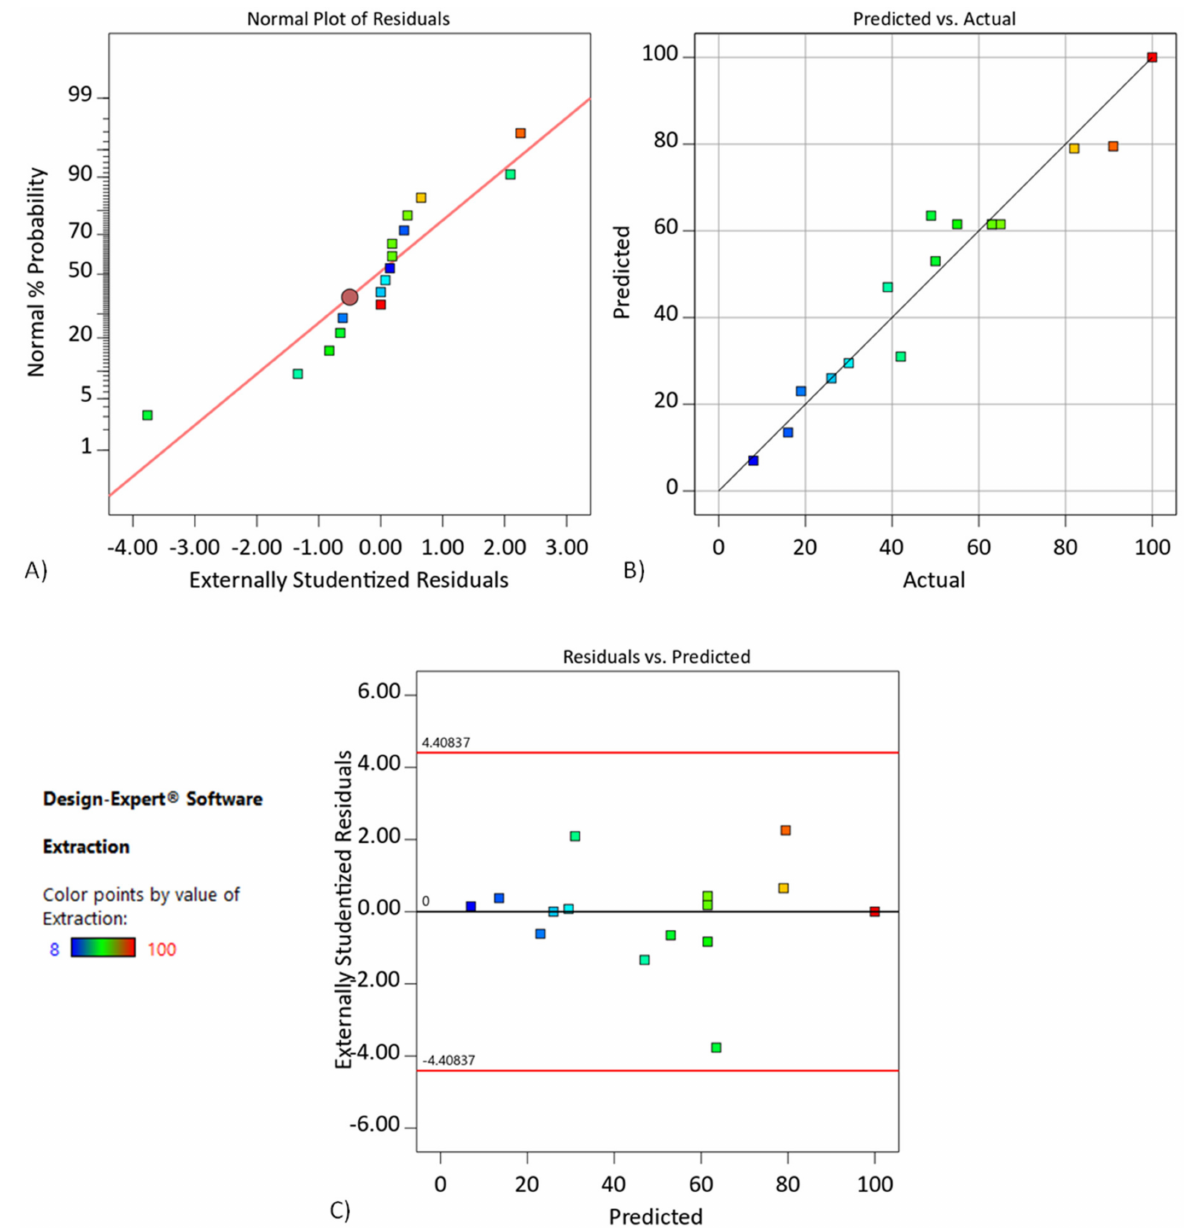
Figure 5. ( A ) The normal probability plot for chromium(III) extraction, ( B ) plot of observed values versus predicted values, and ( C ) plot of residuals versus observed values. DCSLM with threshold concentration of